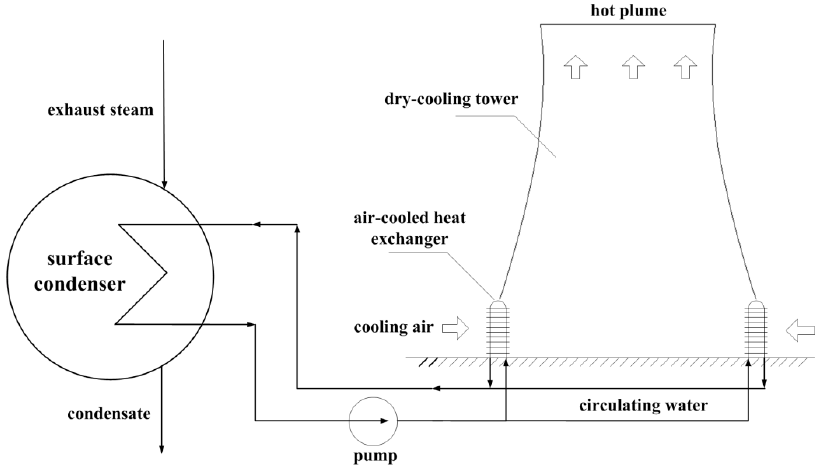
Figure 1. Schematic of cold end with natural draft dry cooling system and surface condenser.